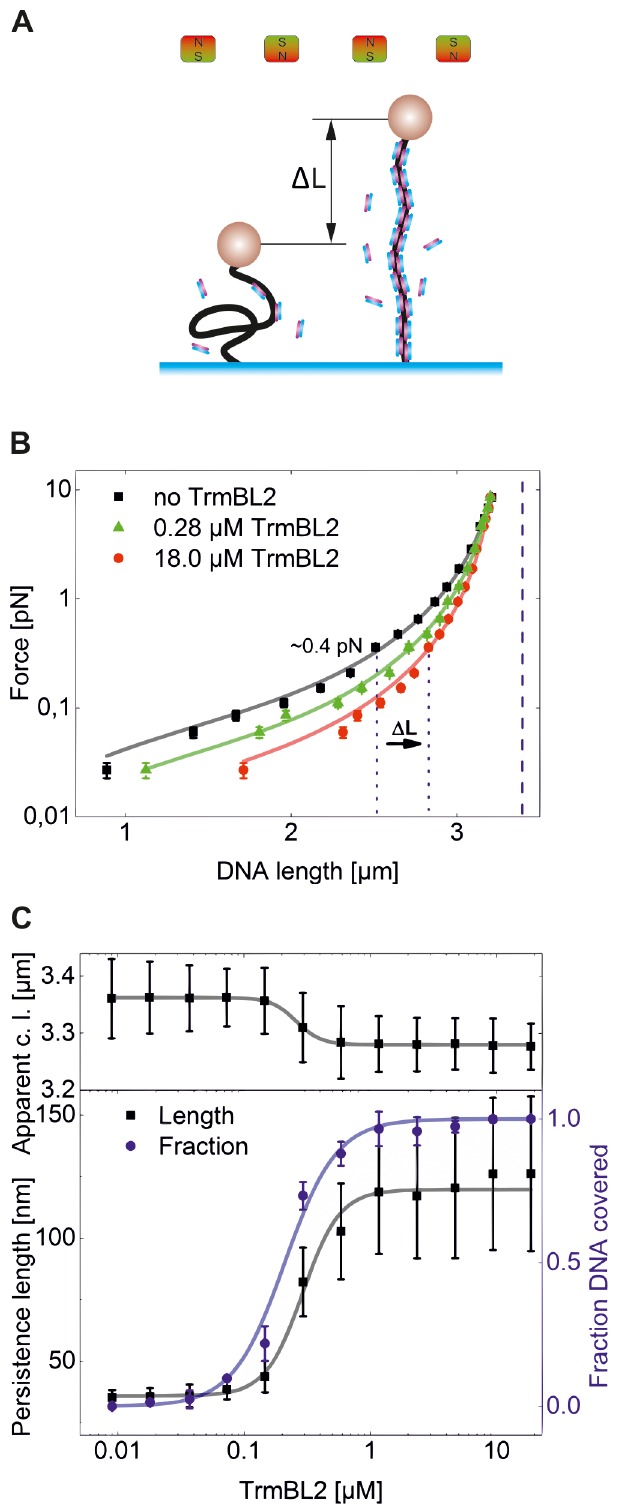
Fig 1. TrmBL2-filament formation on dsDNA. (A) Schematic representation of dsDNA length change as result of TrmBL2 binding. In the absence of protein (left) the bare DNA is in a random coil configuration at low persistence length. Upon protein binding the stiffness of the DNA increases markedly, resulting at low forces